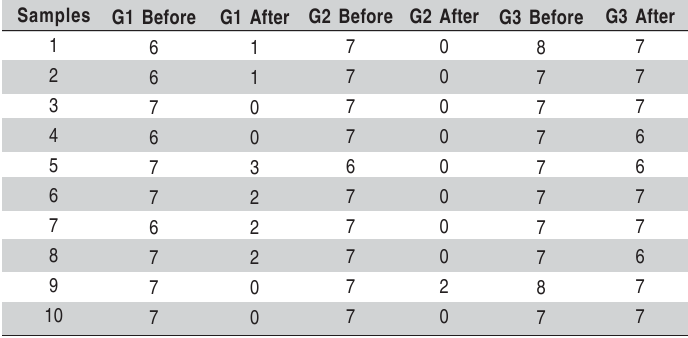
Table 1 - Level of turbidity in the BHI broth containing samples before and after chemomechanical preparation according to McFarland’s standard scale.